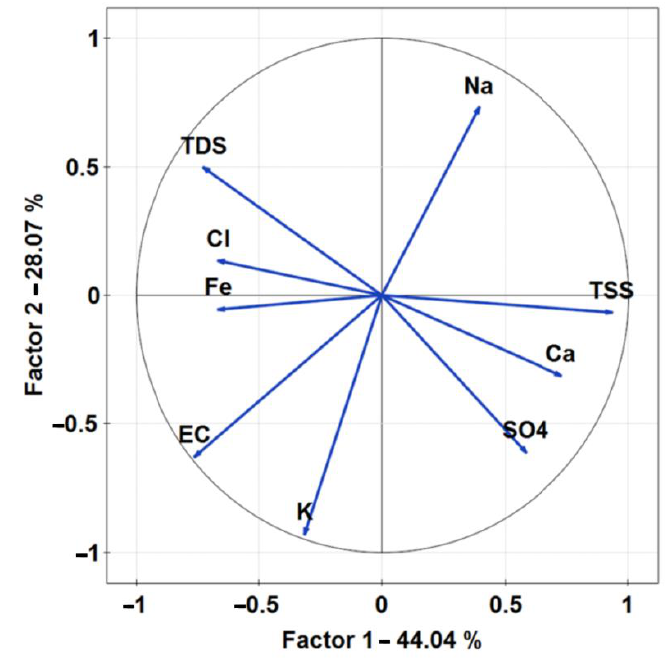
Figure 13. Projected data for physicochemical properties of stream in studied suburban area using PCA.